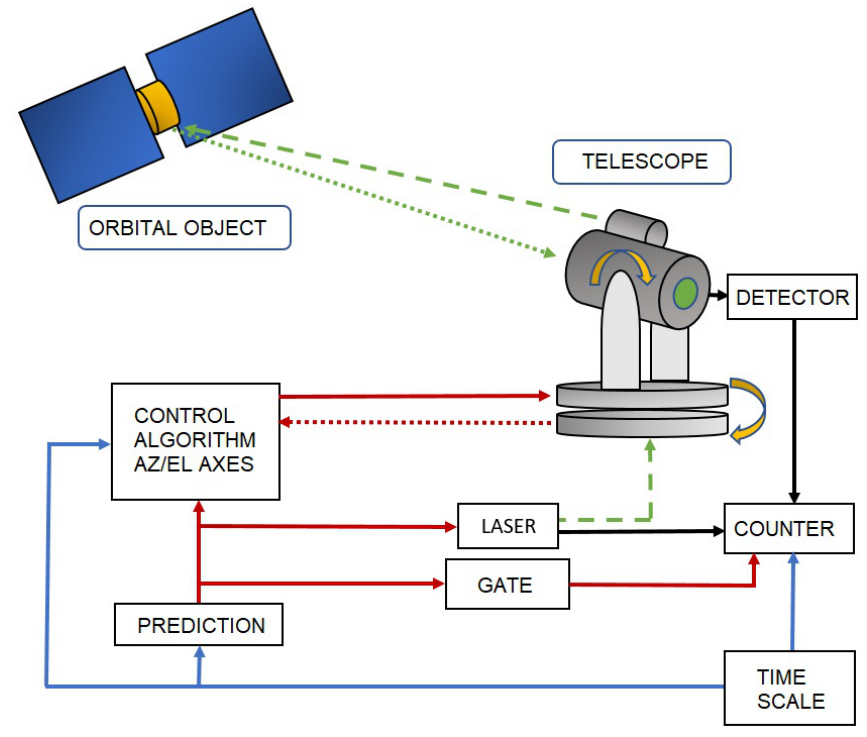
Figure 1. Block diagram of the SLR tracking